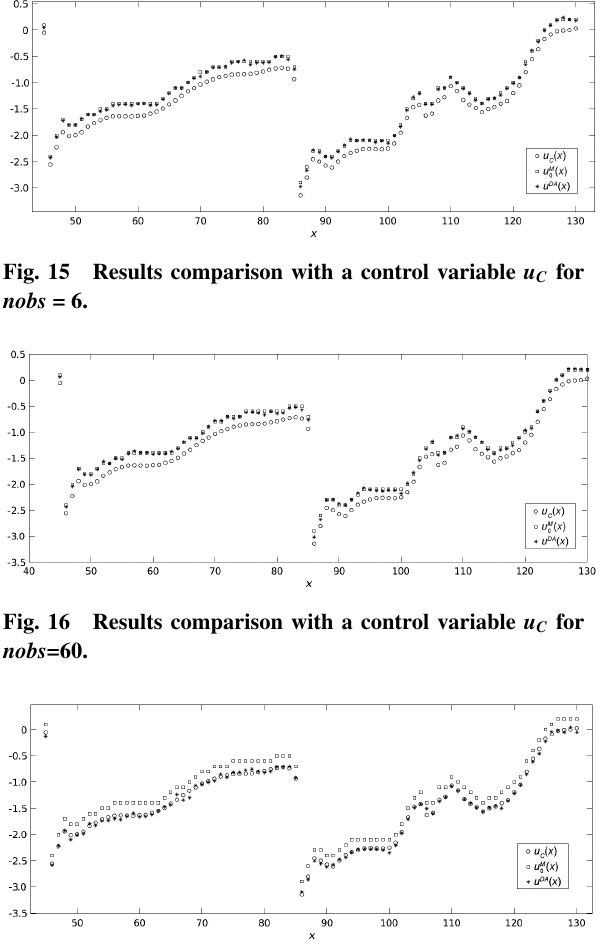
Fig. 17 Results comparison with a control variable u C for nobs